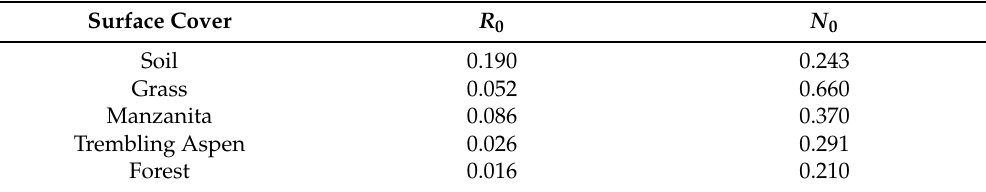
Table 1. Reflectance of typical soil and vegetation in the red (0.662 µ m) and NIR (0.835 µ m) bands